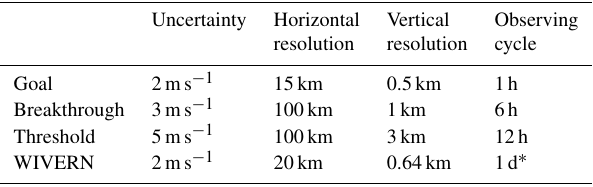
Table 1. WMO (World Meteorological Organization) requirements for horizontal winds for numerical weather prediction (NWP) and the expected performance of WIVERN. Uncertainty Horizontal Vertical Observing resolution resolution cycle Goal 2ms − 1 15km 0.5km 1h Breakthrough 3ms − 1 100km 1km 6h Threshold 5ms − 1 100km 3km 12h WIVERN 2ms − 1 20km